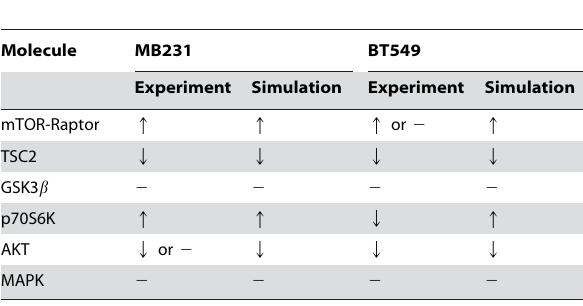
Table 3. Summary of the Effect of Perturbation Reported by Experimental and Simulated